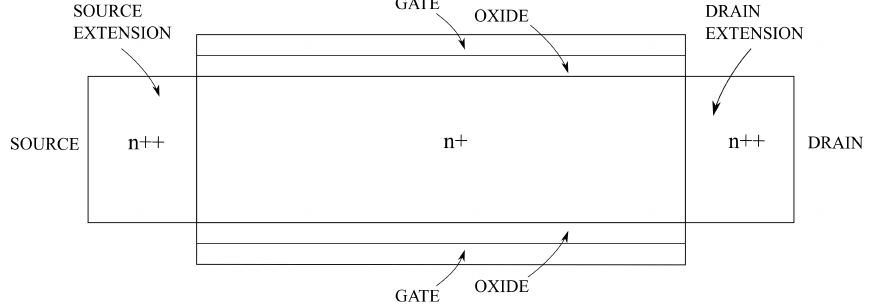
Figure 6. Cross-sectional view of improved cylindrical GAAFET through addition of source and drain